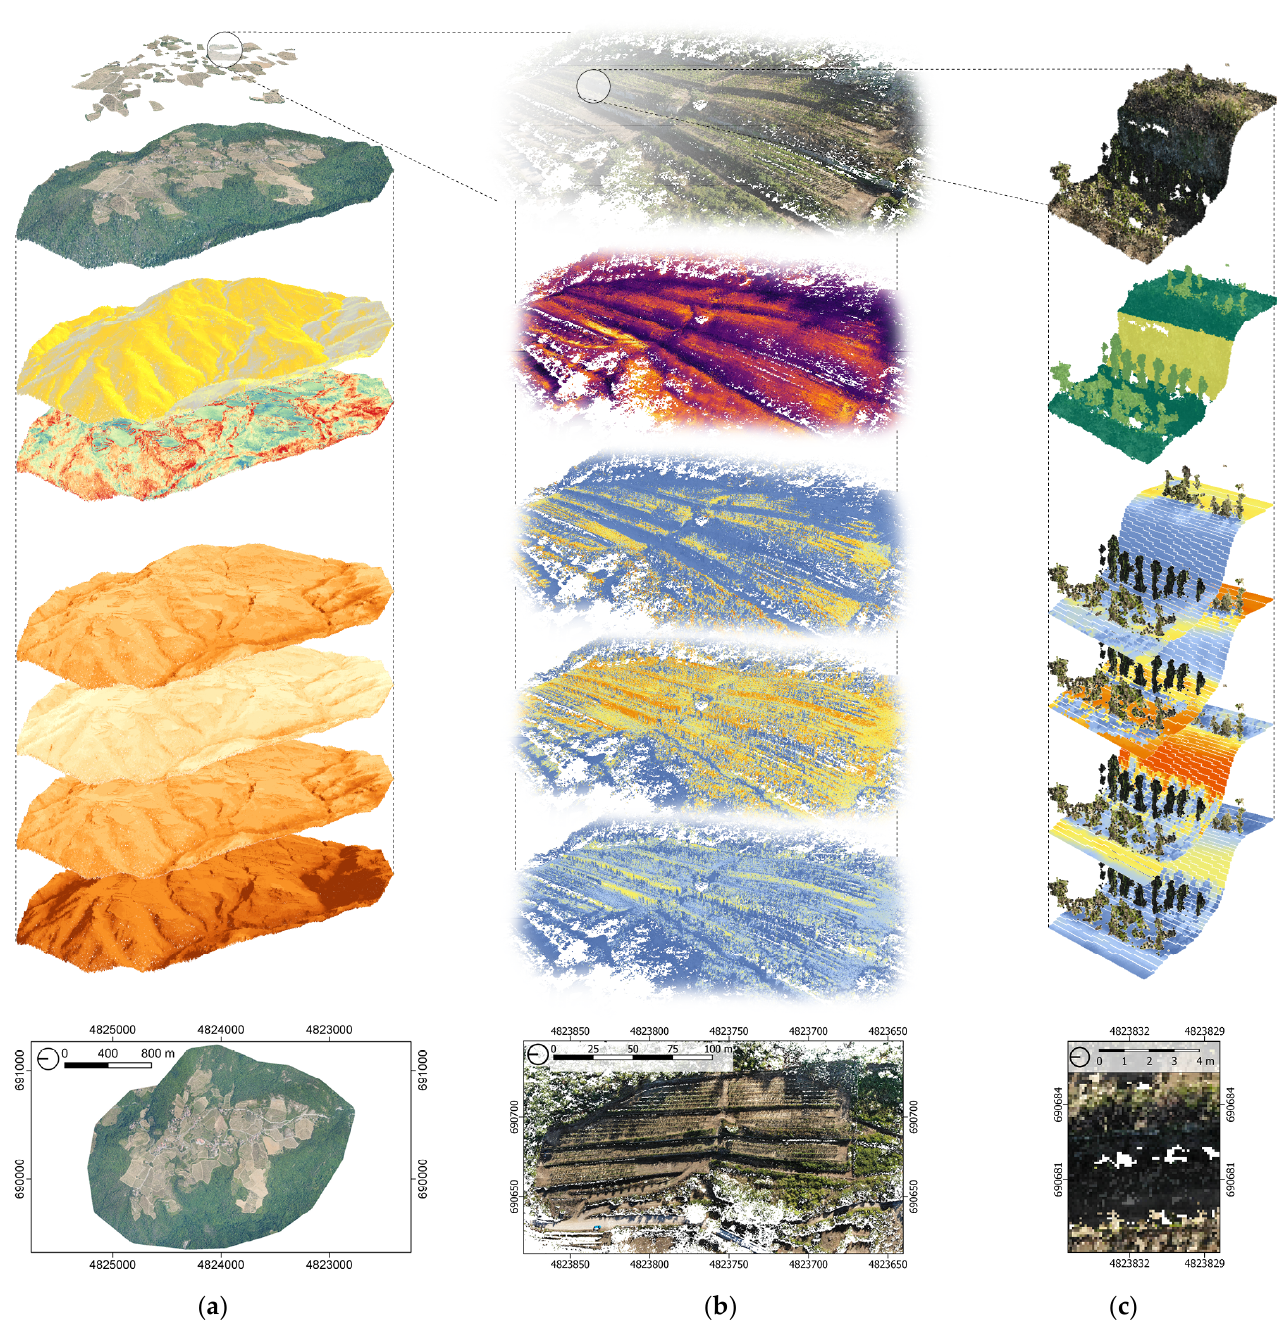
Figure 1. Understanding the interactions between terraced vineyards and their environments requires multi-scale methods. In this study, thermal performance was investigated at three distinct scales: the territorial scale ( a ), the site scale, i.e., individual vineyard ( b ), and the feature scale, i.e., dry-stone walls or plants ( c ). Investigations at each scale were spatially matched, and the same methods and tools were used for each scale to enable correlation of the outcomes.